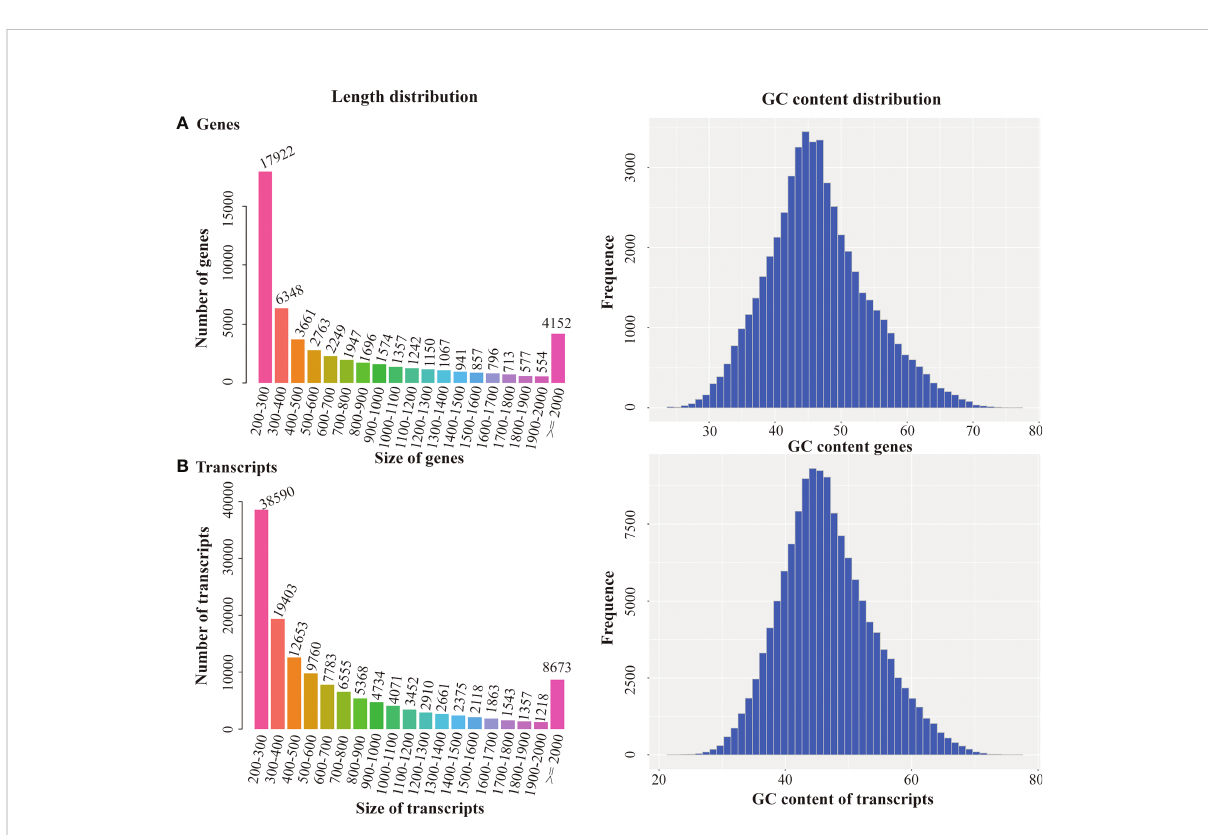
FIGURE 1 Length distribution and GC content distribution of Genes (A) and Transcripts (B) .